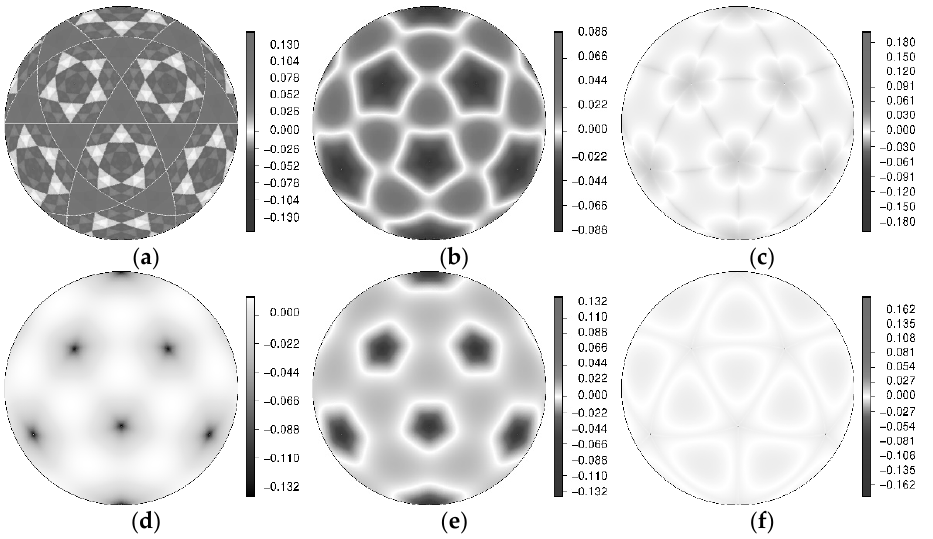
Figure 12. Spherical distributions of D length at level 9. ( a ) NOPT grid. ( b ) SPRG grid. ( c ) HR grid. ( d ) SCVT grid. ( e ) XU grid. ( f ) OURS grid. Same as spherical distribution of grid area, the grids with maximum D length are these pentagons, and distributions of all grids are symmetry. Near these pentagons, the lengths of grids are less than the average length and shown by darker color in all grids. The dis ‐ tribution of NOPT grid has fractal characteristics and is not continuous, too. The D length in the remaining grids are reduced from the pentagons to triangular centers. The grids with larger D length are mainly located along the triangular boundaries in OURS grid, and those grids are spread like pentagon or star from these pentagons.